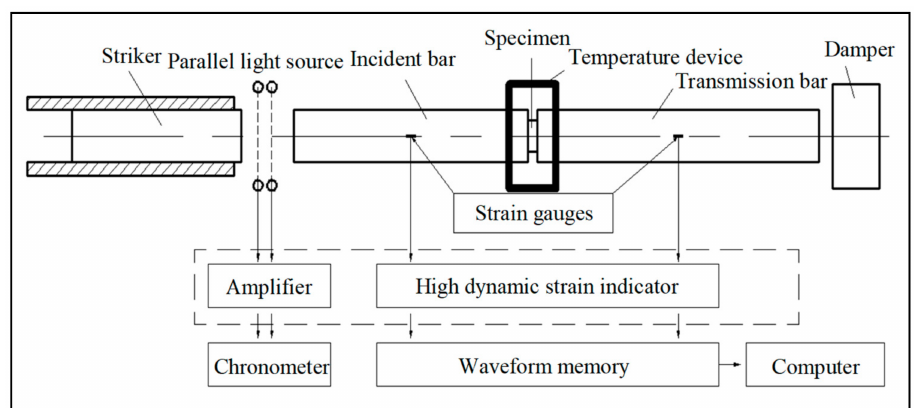
Figure 3. The split Hopkinson pressure bar testing